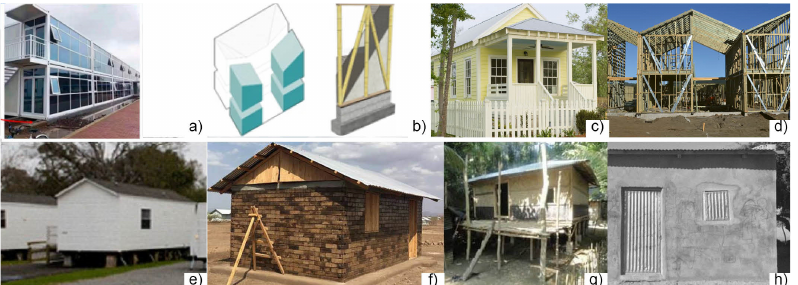
Figure 8. Selected permanent shelters. ( a ) Huoshenshan Hospital, the Chinese government, China, 2020 [60]; ( b ) NovaVida pilot barbaresque project in Ecuador [61]; ( c ) Katrina hurricane’s Cottage in the US, Marianne Cusato (©Marianne Cusato) [49,62]; ( d ) Villa Verde in Chile, Elemental (© Cristian Martinez) [63]; ( e ) Building America Structural Insulated Panel (BASIP), FEMA [49,62]; ( f ) Turkana houses prototypes in Kenya, Shigeru Ban architects (© United Nations Human Settlements Pro ‐ gramme, 2020) [64]; ( g ) Bandarban for recurring flood in Bangladesh, machan model [23,65]; ( h ) Emergency prolongation in Chad; Shelter Cluster (©2022 UNHCR-E. Zorawska) [39,50]. The matrix, as shown in Figure 9, shows shelters in rows and structurally related indicators in columns. Darker green colour shades indicate compliance with the indicator’s criteria, and darker orange colours indicate non-compliance. Gray indicates an area with insufficient information. It is important to note that the matrix cannot be used to compare case studies, but rather to give a graphical representation of critical areas. The depicted shelters also showcase the variety of structural typologies within the vertical structure. Buildings 2023 , 13 , x FOR PEER REVIEW